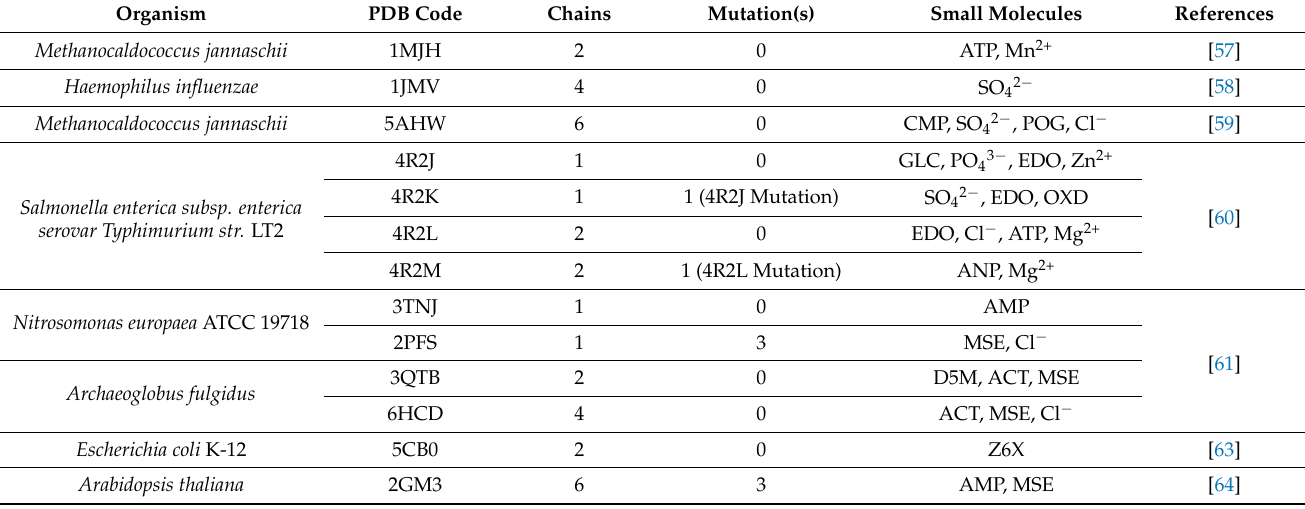
Table 2. Summary of crystal structures of USP family proteins.